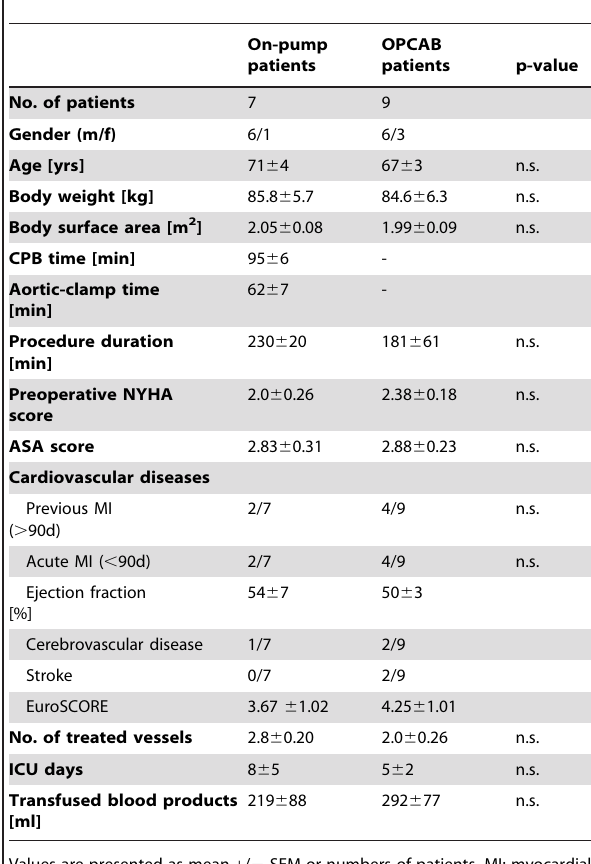
Table 1. Demographic and clinical patient